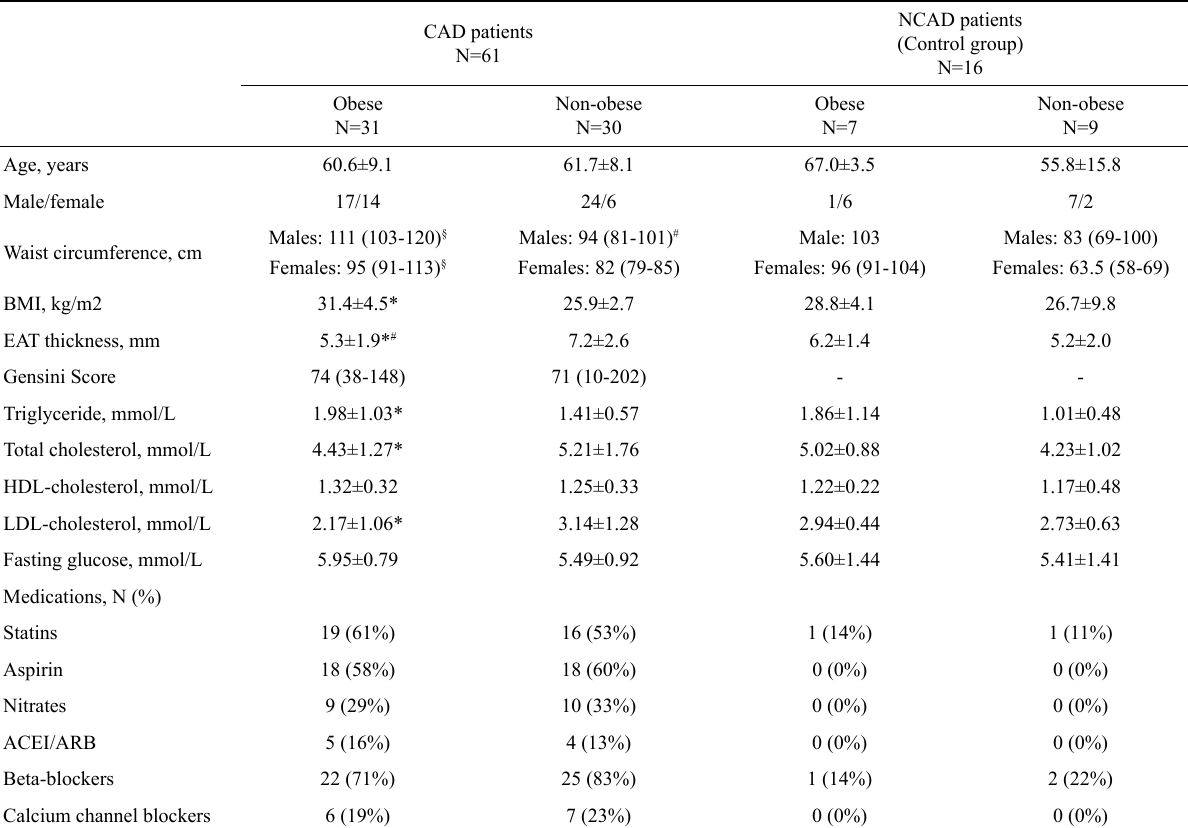
Table 1 ‒ Clinical and biochemical characteristics of the studied groups with detailed